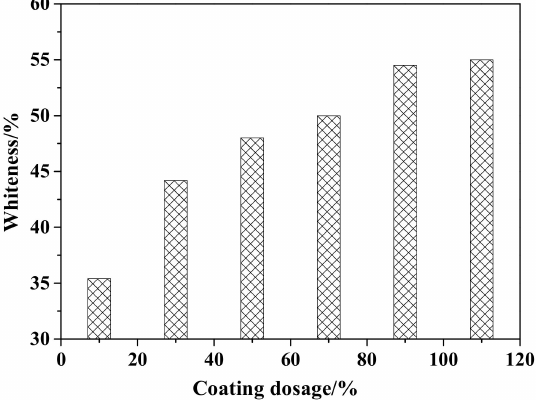
Figure 2. Whiteness of ZCFA powder with di ff erent coating dosages.